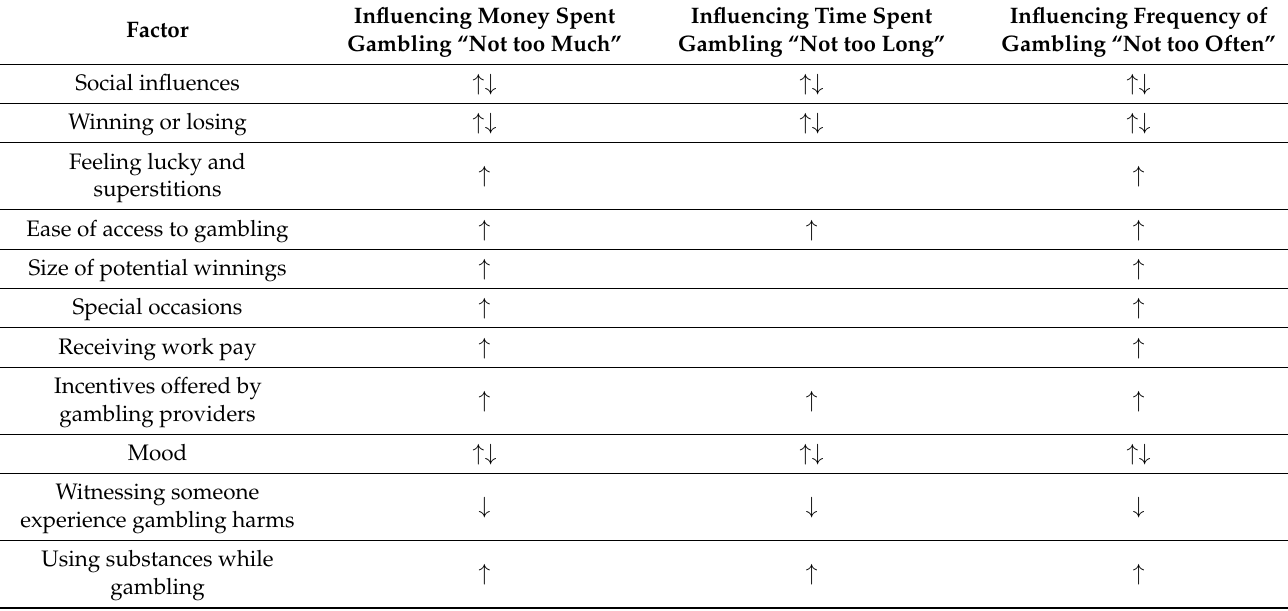
Table 2. Factors influencing the efficacy of self-control